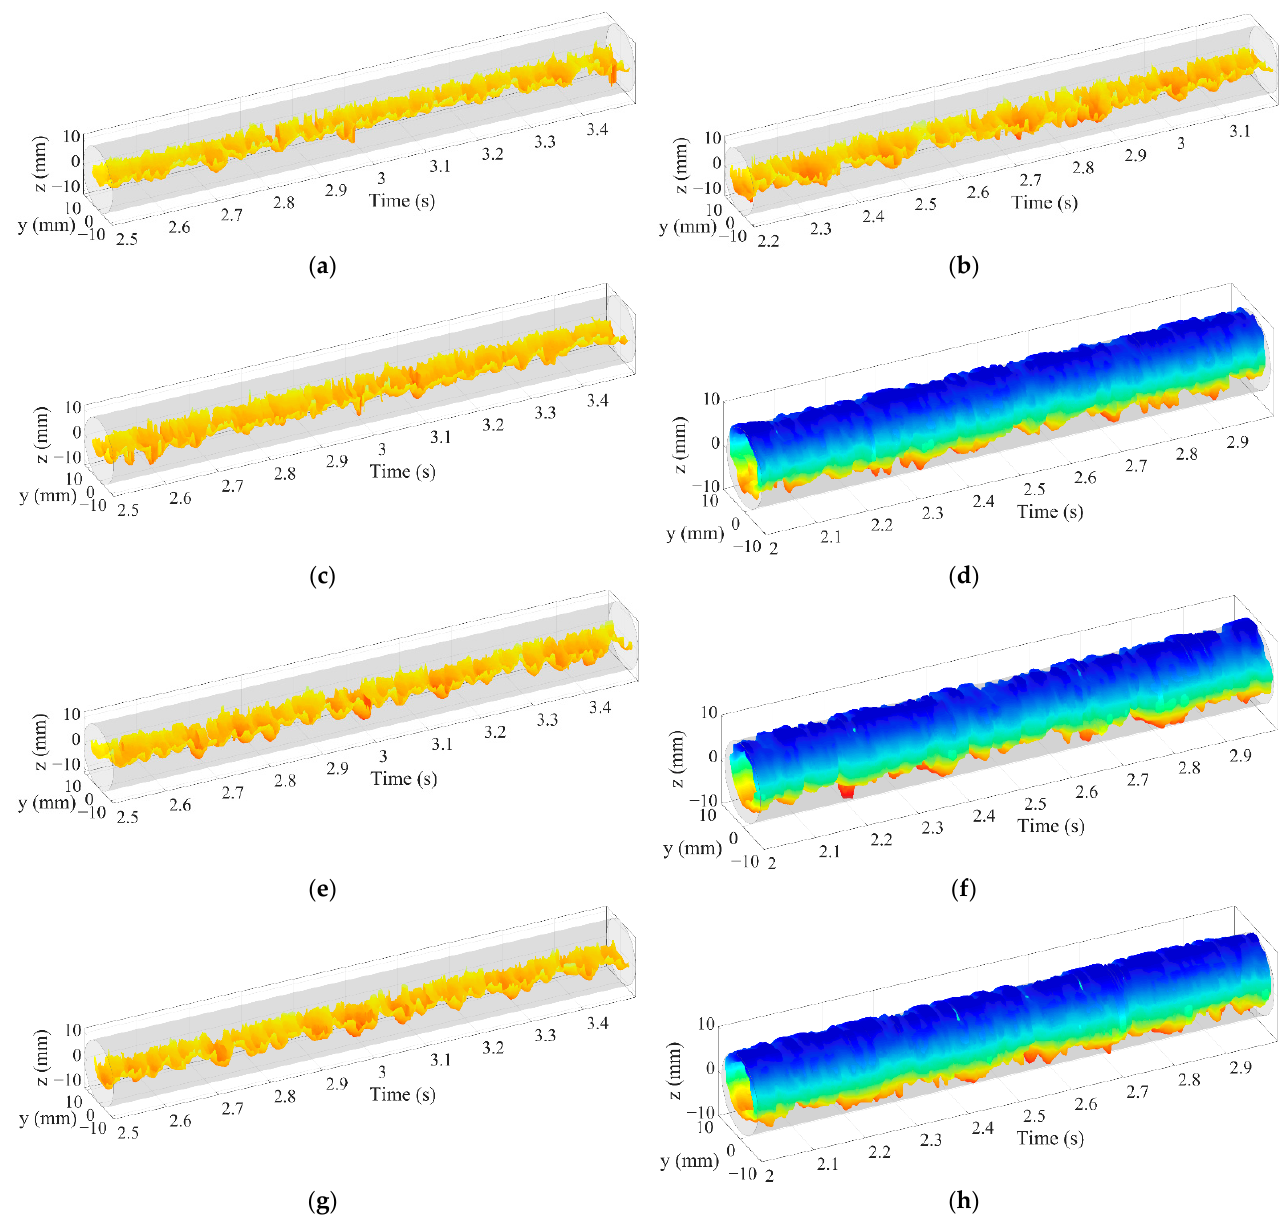
Figure 19. Evolution characteristics of oil–water interfacial configuration at different pipe inclinations ( U sw = 0.737 m/s): ( a ) U so = 0.368 m/s, D W/O&D O/W, 0°; ( b ) U so = 0.921 m/s, D W/O&D O/W, 0°; ( c ) U so = 0.368 m/s, D W/O&D O/W, +5°; ( d ) U so = 0.921 m/s, D W/O&D O/W WF, +5°; ( e ) U so = 0.368 m/s, D W/O&D O/W, +10°; ( f ) U so = 0.921 m/s, D W/O&D O/W WF, +10°; ( g ) U so = 0.368 m/s, D W/O&D O/W, +15°; ( h ) U so = 0.921 m/s, D W/O&D O/W WF, +15°.